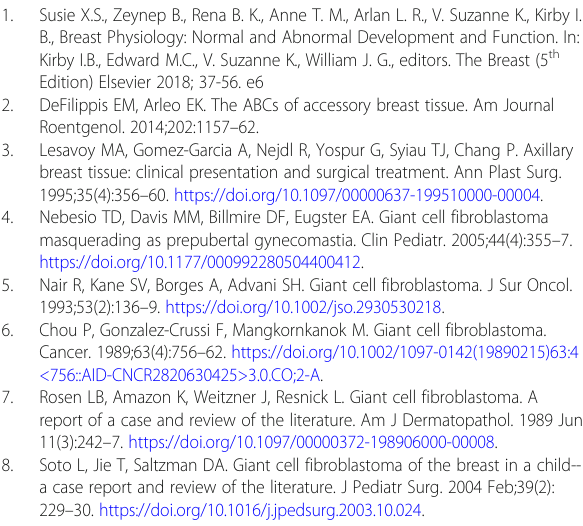
Abbreviations ER: Estrogen receptors; PR: Progesterone receptors; Fig.: